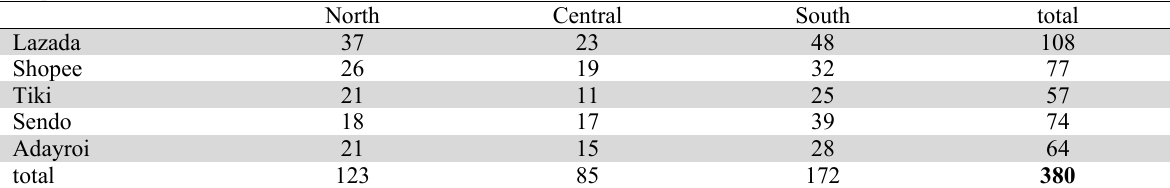
Sample distribution